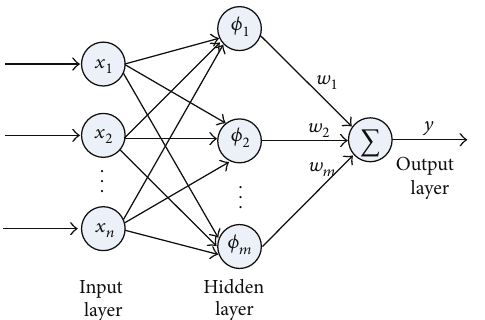
Figure 2: Architecture of RBF network.